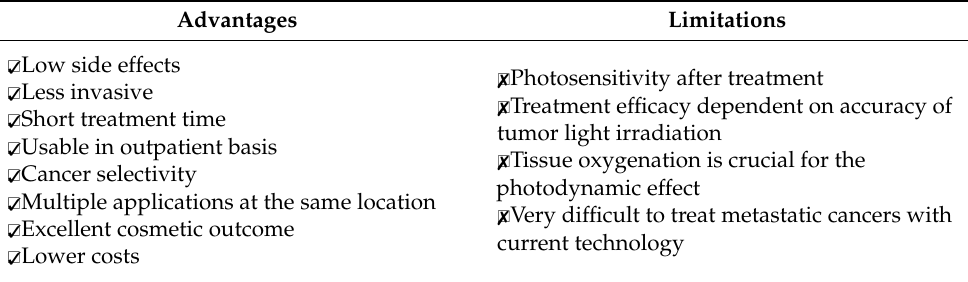
Table 3. Summary of the main advantages and disadvantages of